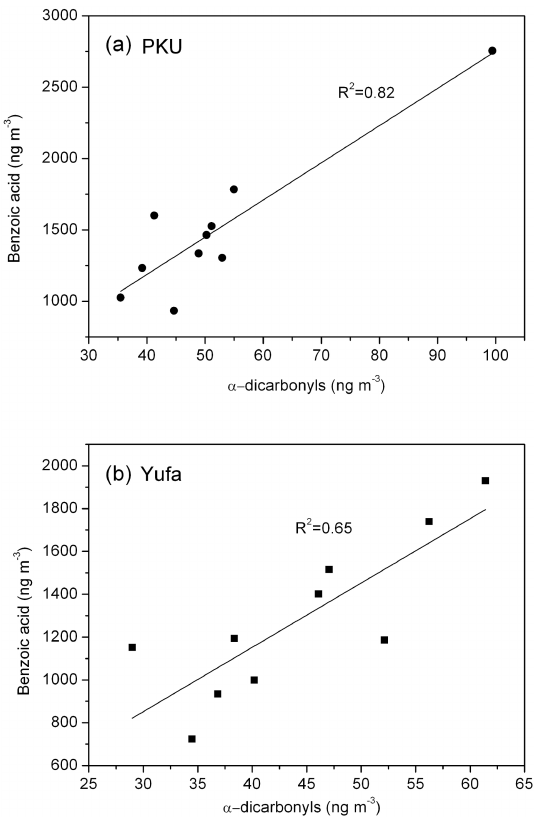
Figure 4. Positive correlation between α -dicarbonyls and benzoic acid observed at PKU (a) and Yufa (b)